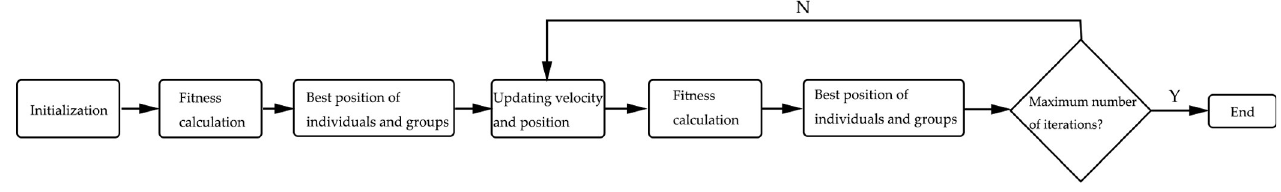
Fig 15. PSO algorithm